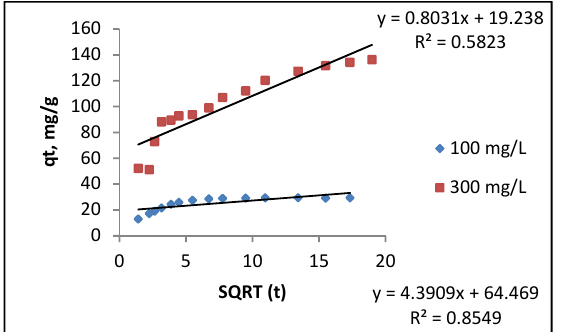
Fig.8. Intraparticle diffusion model for adsorption of MB on AC